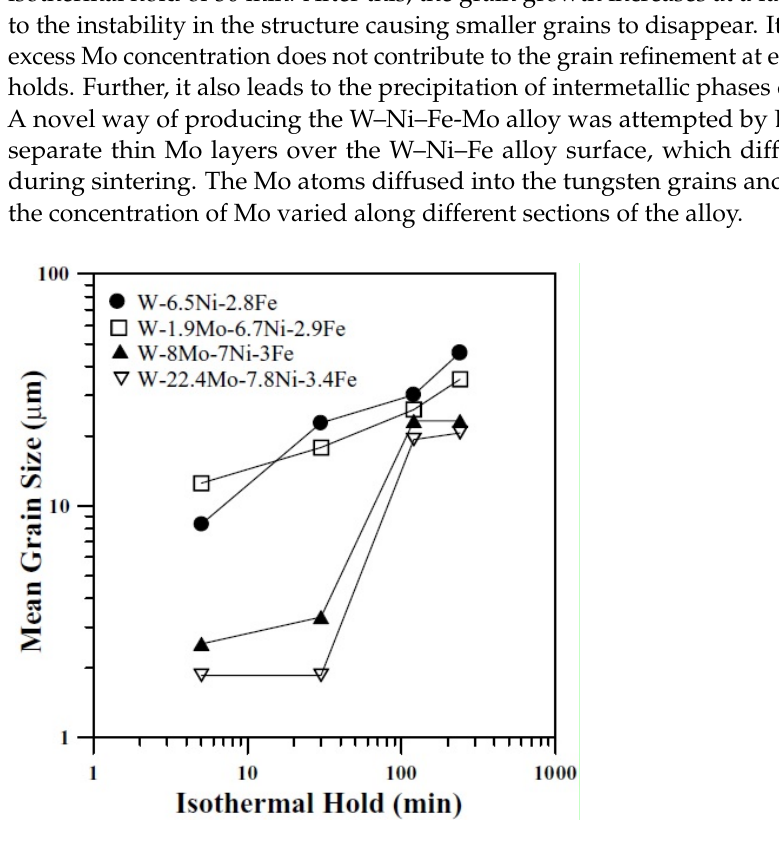
Figure 5. Variation in mean grain size with sintering holding time [60]. Reproduced with permission from Hsu et al., Journal of Materials Science; published by Springer, 2003.